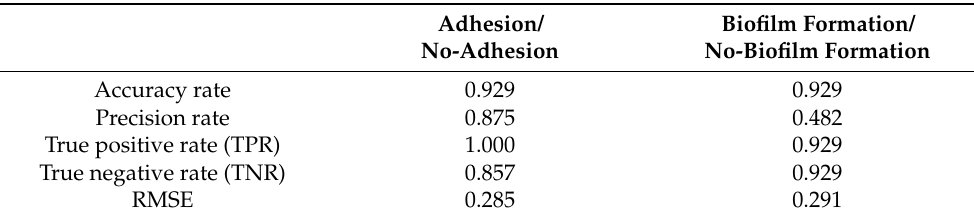
Table 5. Confusion matrices for validation of adhesion/no-adhesion or biofilm formation/no-biofilm formation of L. monocytogenes ST9, based on thresholds